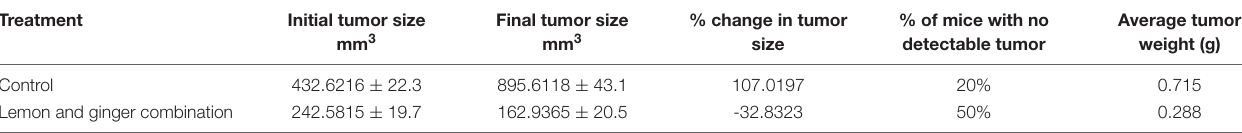
TABLE 3 | Effect of lemon and ginger combination water extract on tumor size and cure percentage.